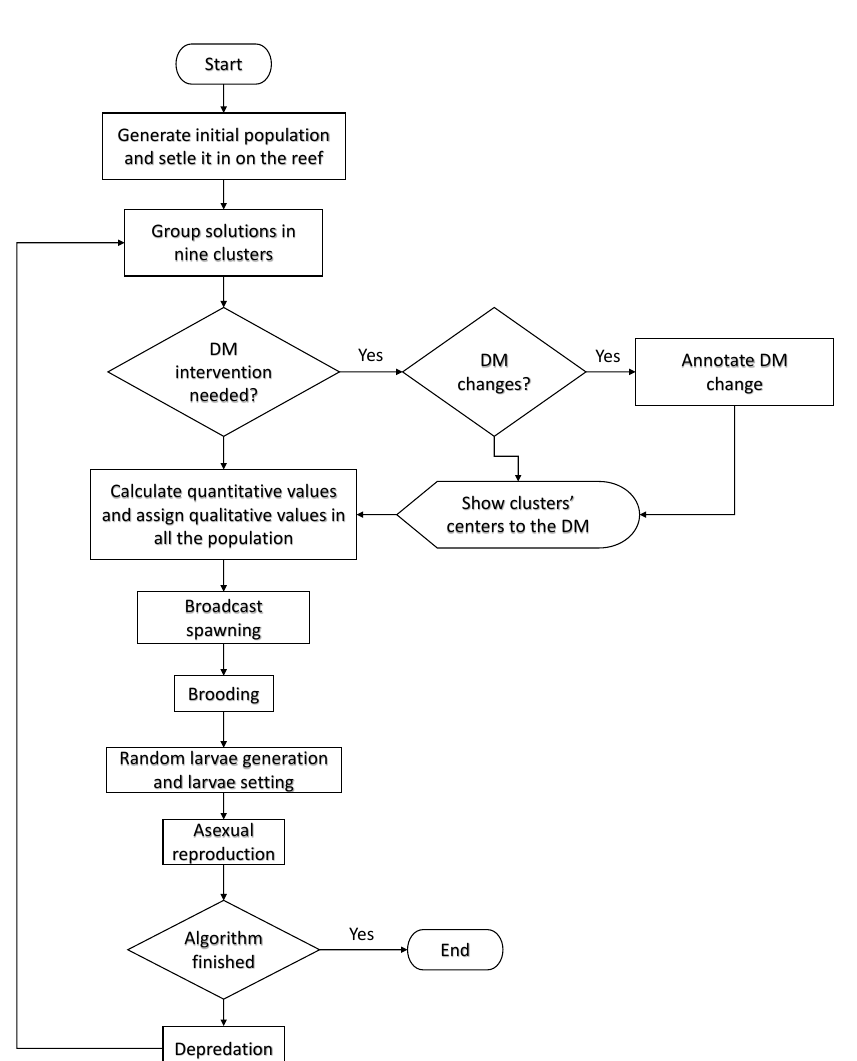
Figure 3. Flow diagram of the algorithm with DMs’